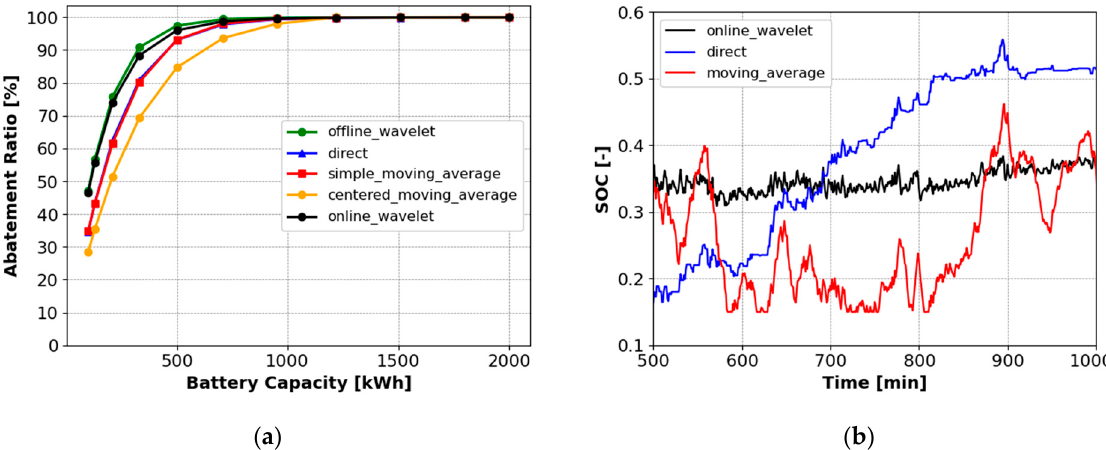
Figure 25. Real-time control un comparison with the other methods: ( a ) AR vs. Battery Capacity ( b ) SOC profile.